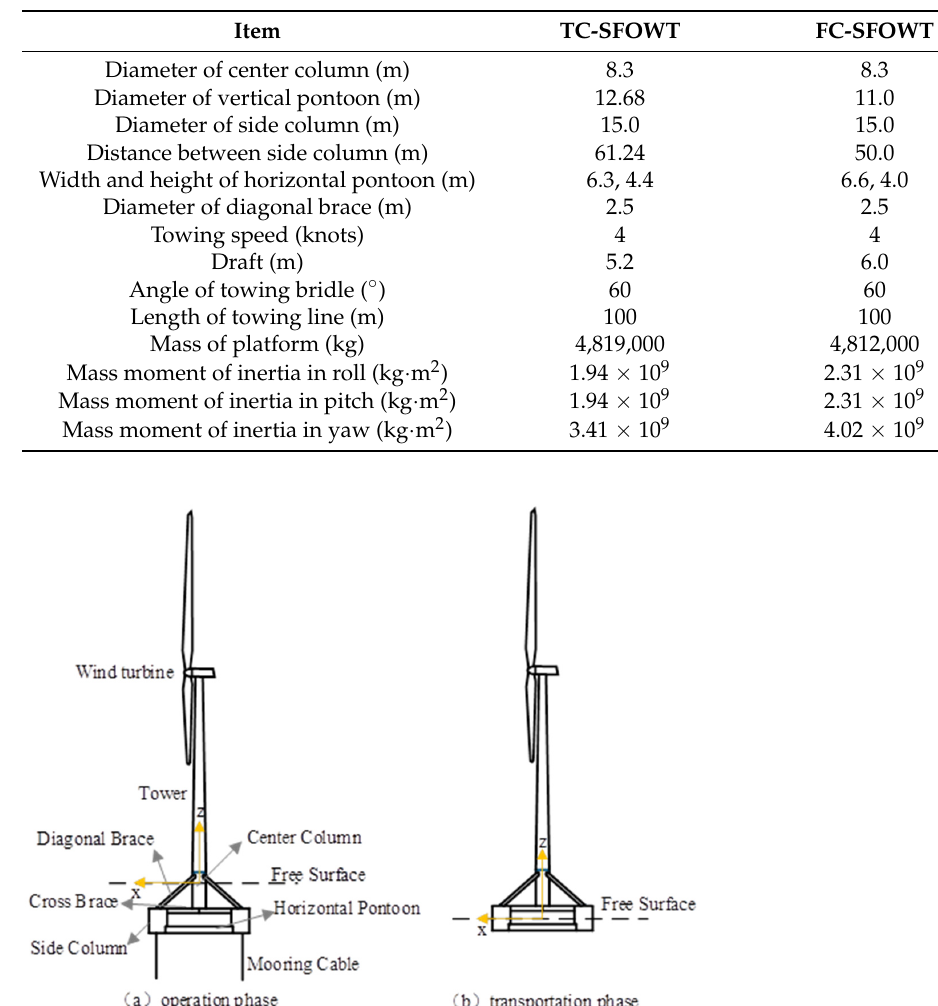
Table 2. Main parameters of the towing system of SFOWTs.